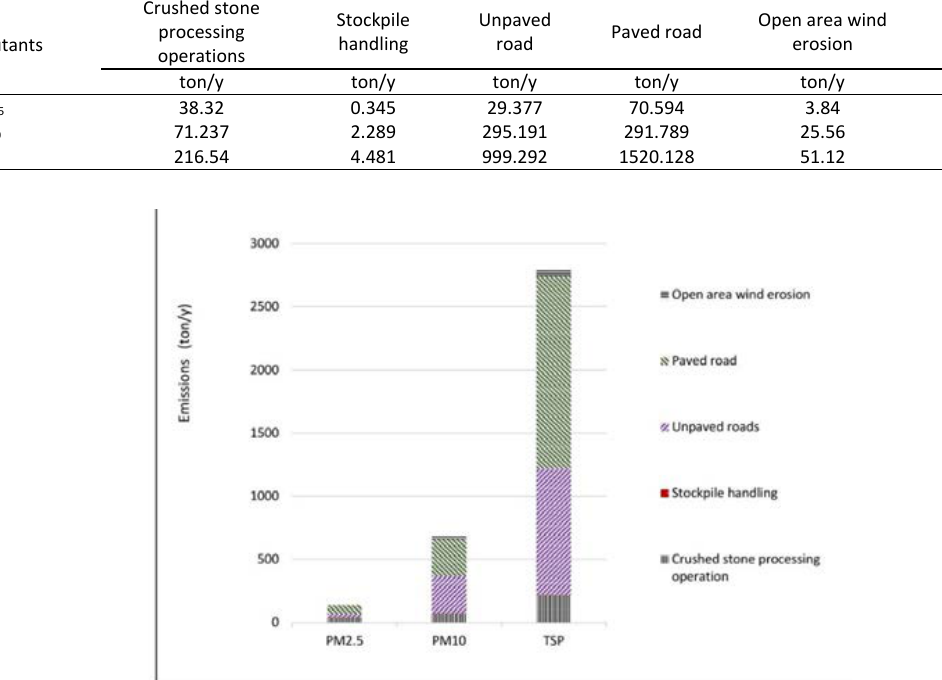
Fig. 4: PM PM and TSP emissions from the sand and gravel mining 2.5, 10 Fig. 4: PM 2.5, PM 10 and TSP emissions from the sand and gravel mining processes